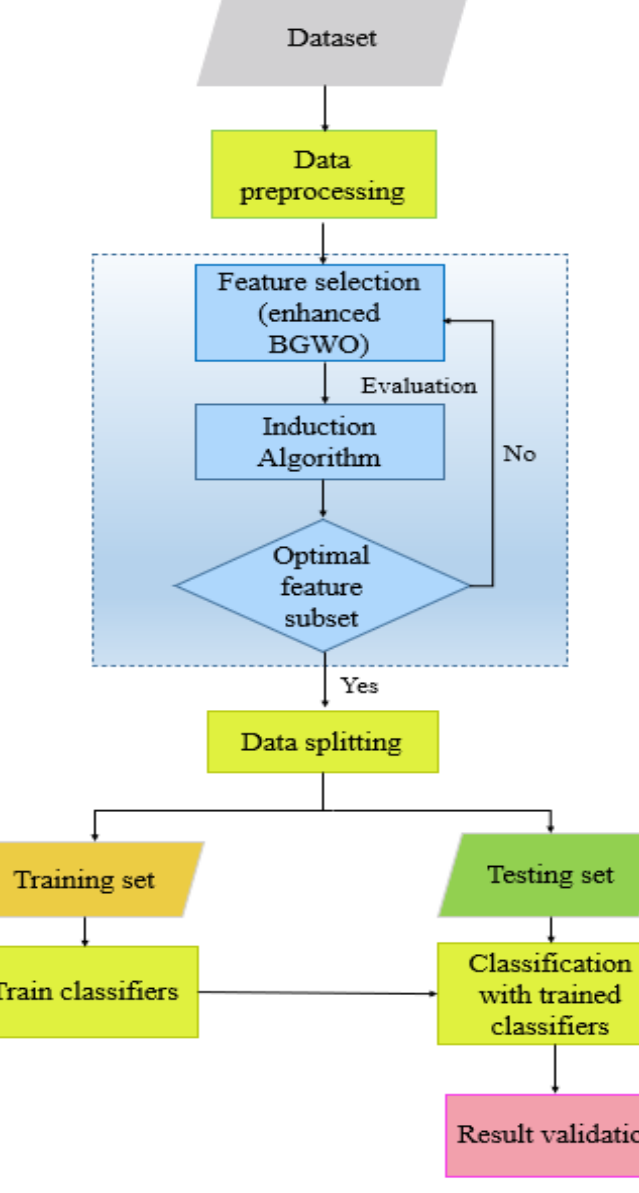
Figure 2. Proposed model applying machine learning algorithms.